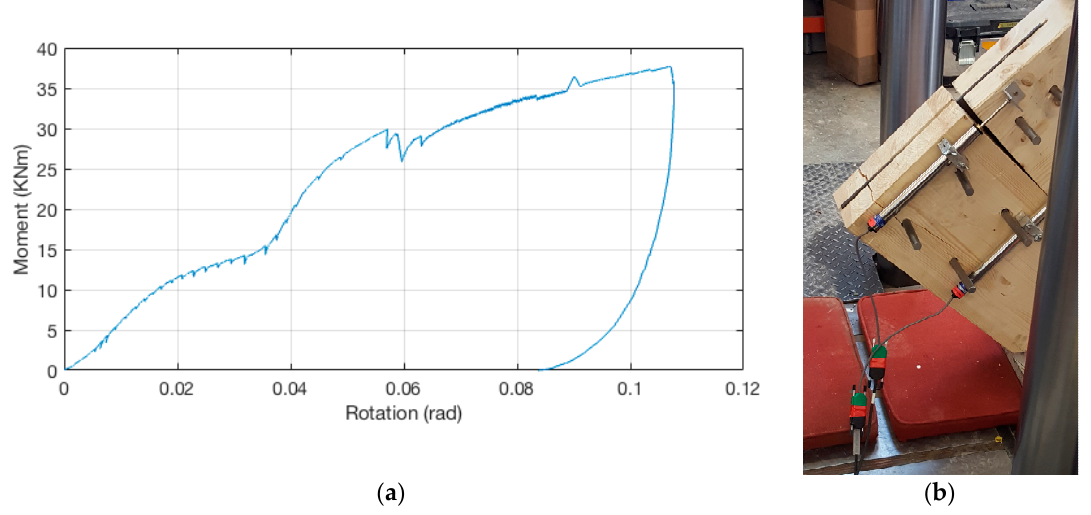
Figure 4. Connection test results: ( a ) moment-rotation diagram of the dowelled connection; ( b ) connection specimen at failure.